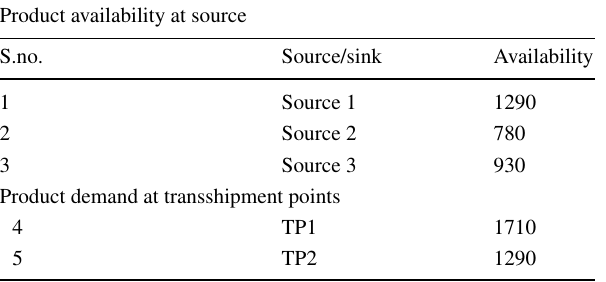
Table 1 Product availability and demand at source and TP Product availability at source